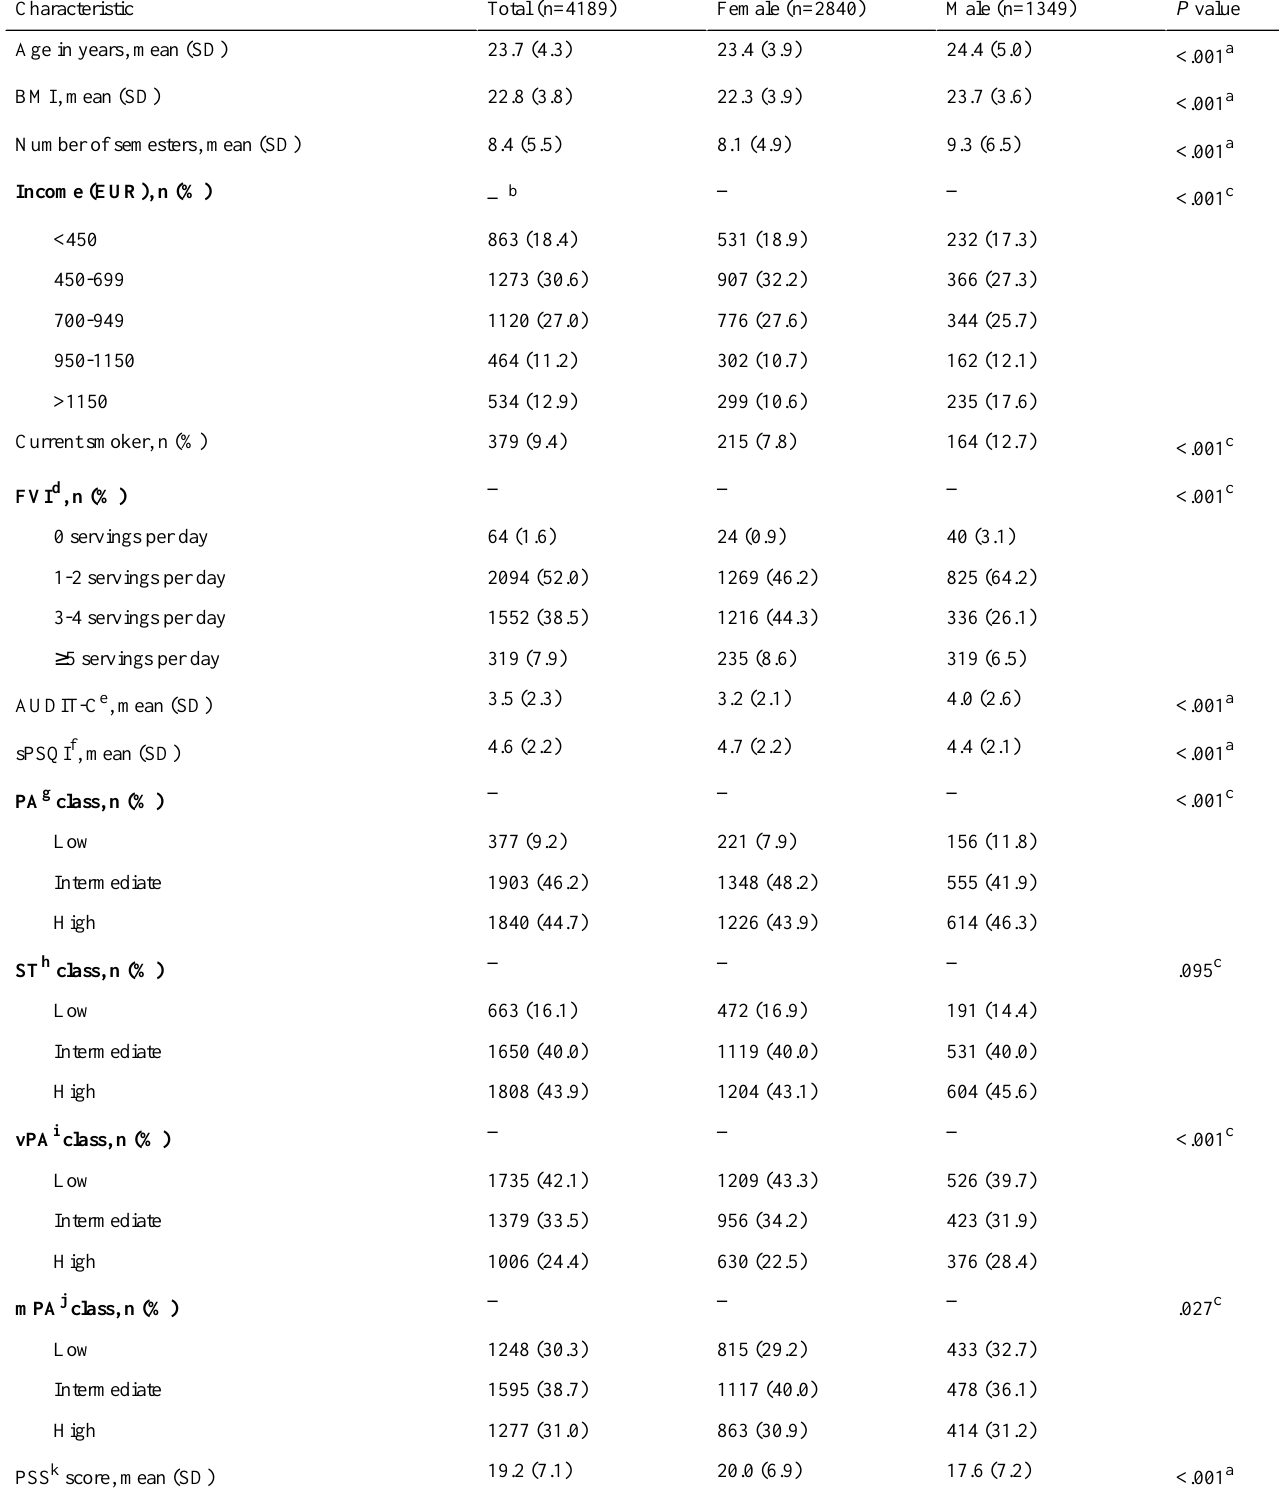
Table 1. Characteristics of university students by